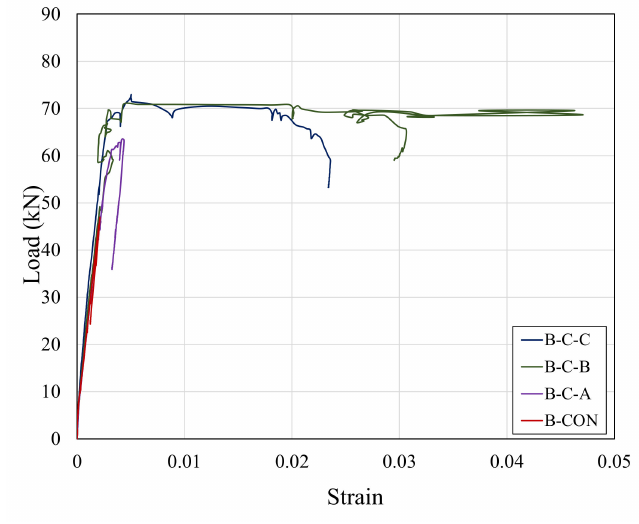
Figure 15. Load-strain curves of control and hemp FRRP strengthened